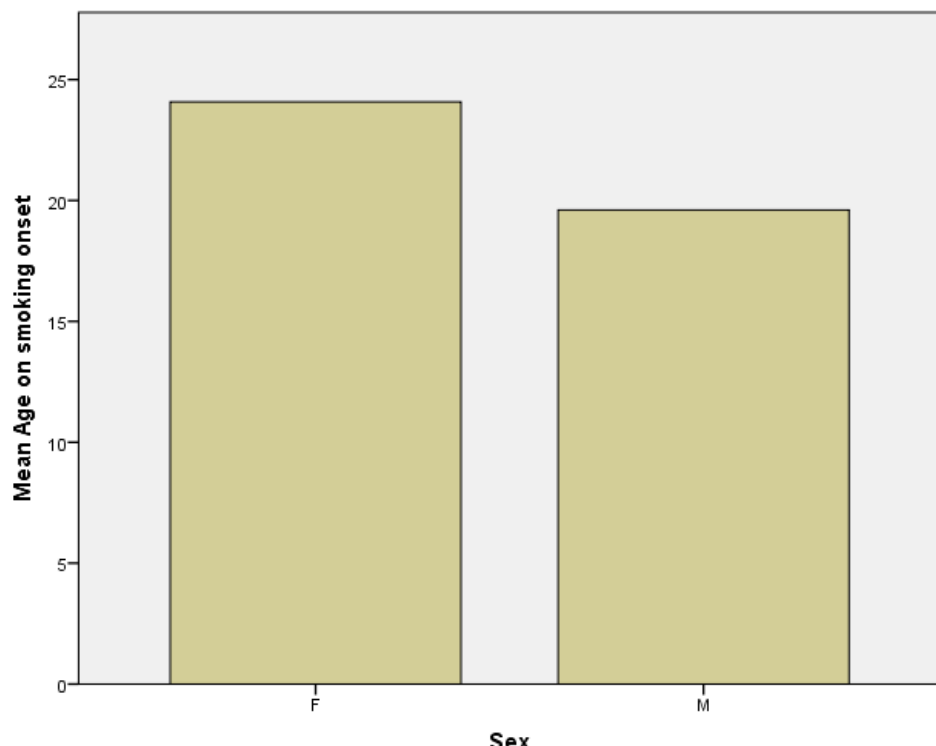
Figure 4. Age at smoking onset in females (F) and males (M) subgroups. Thirdly, regarding the smoking period, in the female subgroup the mean smoking period is 27.19 years versus 26.58 years in the male subgroup (Figure 5).